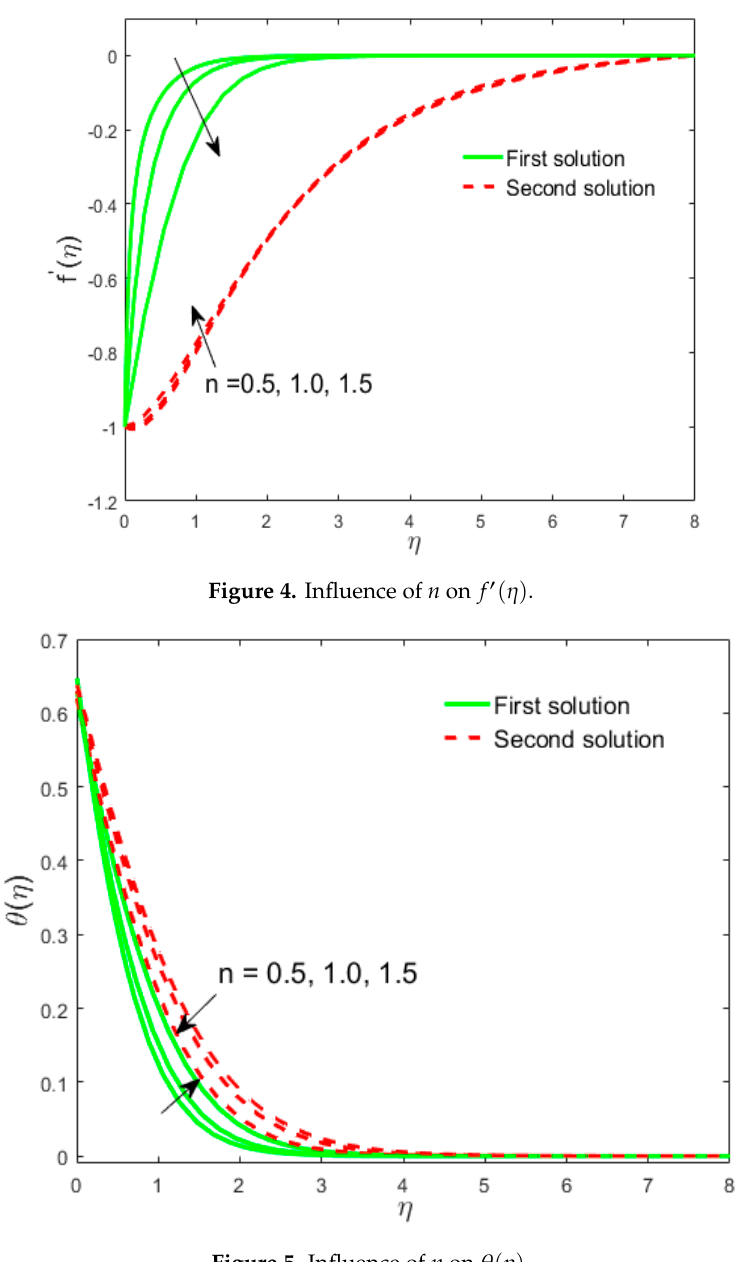
Figure 5. Influence of n on θ ( η )